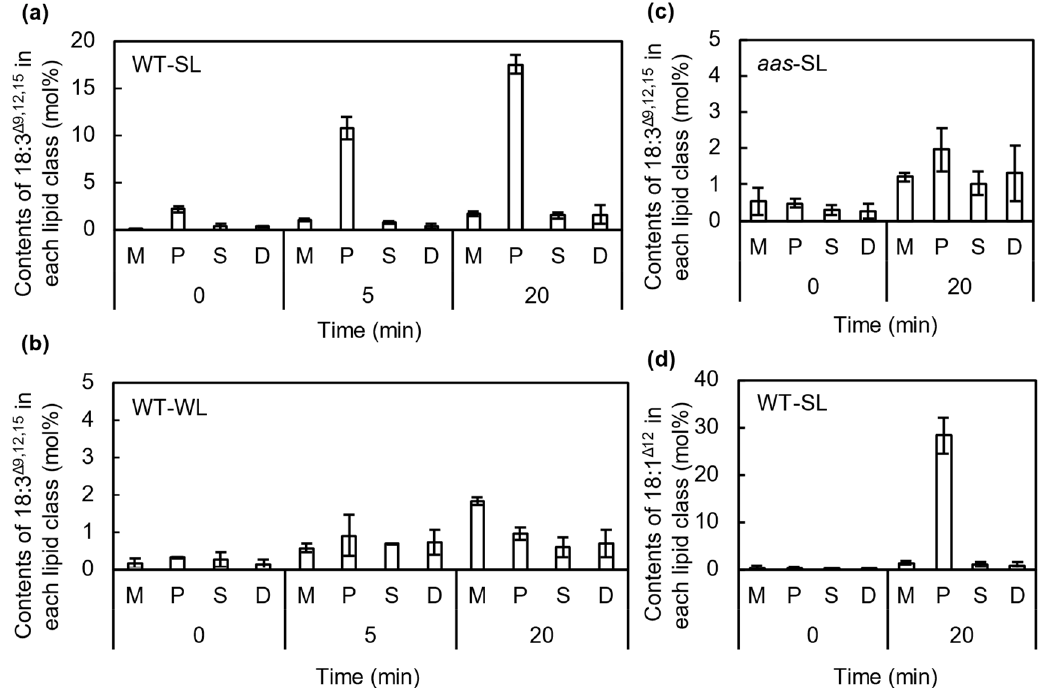
Figure 4. Specific incorporation of unsaturated C18 fatty acids into phosphatidylglycerol (PG) molecules via acyl-ACP synthase (AAS). The content of 18:3 Δ 9,12,15 incorporated into membrane lipids in wild-type ( a ) or aas cells ( c ) under strong light (SL) at 1500 μ mol photons m − 2 s − 1 or weak light (WL) at 70 μ mol photons m − 2 s − 1 ( b ) was analyzed by thin-layer chromatography (TLC) and gas chromatography (GC). M, MGDG; P, PG; S, SQDG; D, DGDG. Content of 18:1 Δ 12 incorporated into the membrane lipids under SL at 1500 μ mol photons m − 2 s − 1 for 20 min was also analyzed by TLC and GC ( d ). Values are the means ± SD (bars) of three independent experiments.